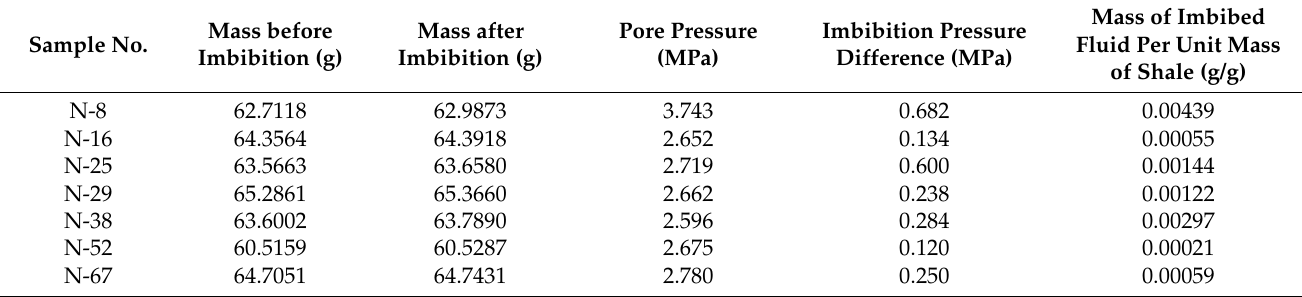
Table 3. The mass change of shale samples before and after fracturing fluid imbibition.